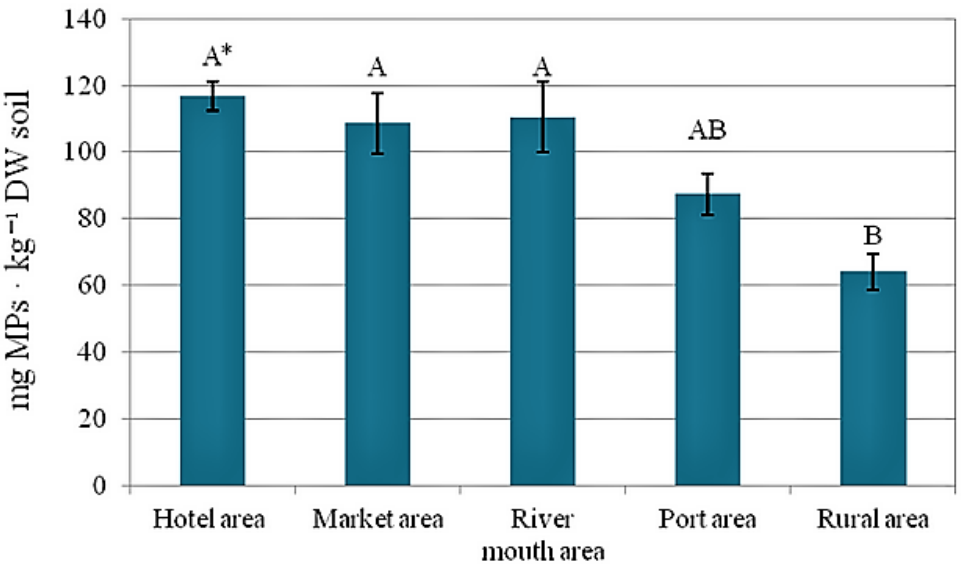
Figure 2. Weight of MPs in the soil from five mangrove areas in Bima City Bay. Data are mean ± SE, n = 5. * Capital letters indicate significant differences between weights of MP.